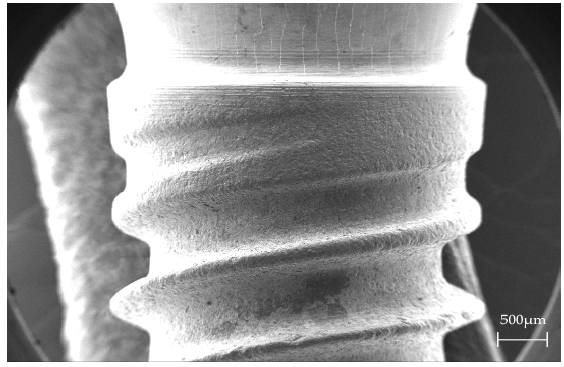
Figure 5. SEM-Image of a whiteSKY zirconia implant, 45-fold magnification. According to the manufacturer, the micro-rough surface in the region of the threads is achieved using sand-blasting (Figure 6).